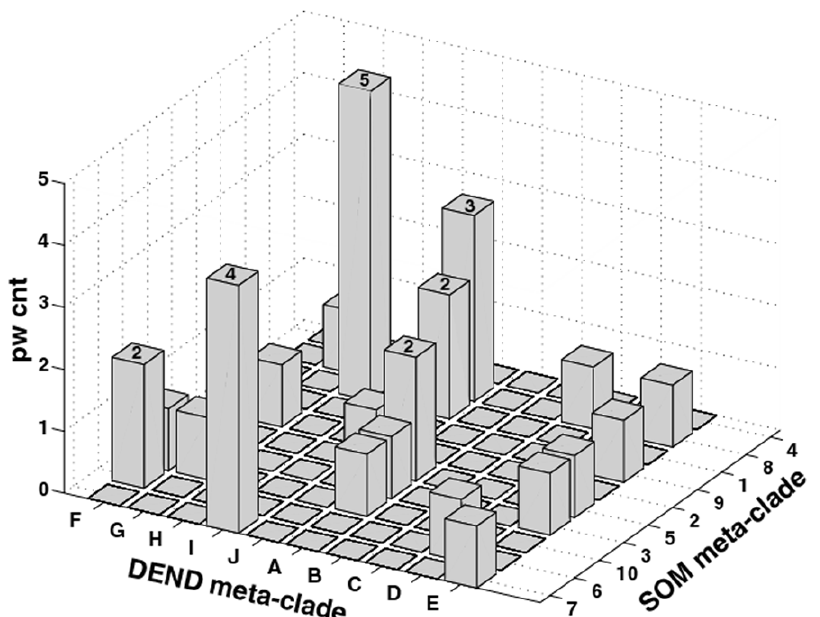
Figure 6. Three-dimensional histogram for count of pathways (pw cnt) shared from the GSEA analysis of gene expressions derived from the patient pooled/ASPS-1 data (axis labels DEND meta-clade, with clade letters A–J) and the individual patient data (axis labeled SOM meta-clades, with meta-clades numbered 1–10). Genes designated with an asterisk are common to pathways identified using the ASPS-tissue: ASPS-1 data set and the individual patient